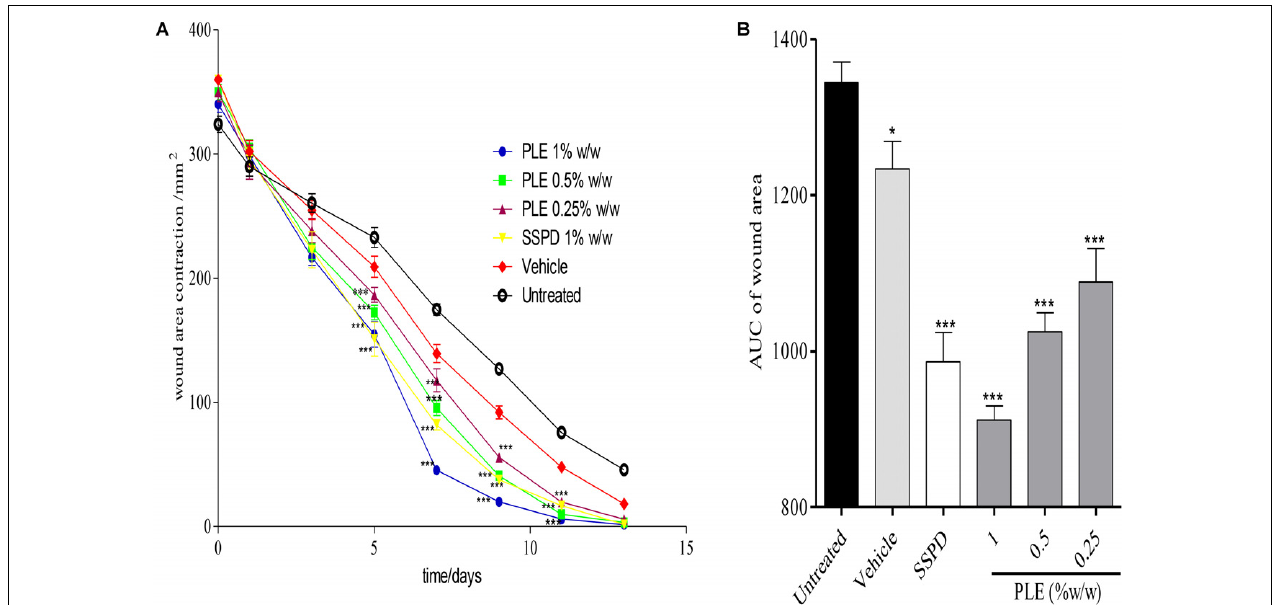
FIGURE 1 | Influence of PLE on rate of wound closure. Full thickness wounds of approximately 20 mm in diameter were excised on the dorsal region of rats. The excised wounds were topically treated with 0.25, 0.5, and 1% w/w PLE formulated as aqueous cream. Wound diameter was measured on days 1, 3, 5, 7, 9, 11, and 13 post injuries. (A) Time-course curve, (B) area under curve (AUC) of time course curve. PLE: aqueous extract of the aerial parts of P. muellerianus . Vehicle group was treated with aqueous cream base. SSPD: 1% w/w silver sulphadiazine-treated wounds (positive control). Values are mean ± SEM, n = 5. ∗∗∗ p < 0.001; ∗∗ p < 0.01; ∗ p < 0.05 compared to untreated group (two-way ANOVA followed by Bonferroni’s post hoc test).